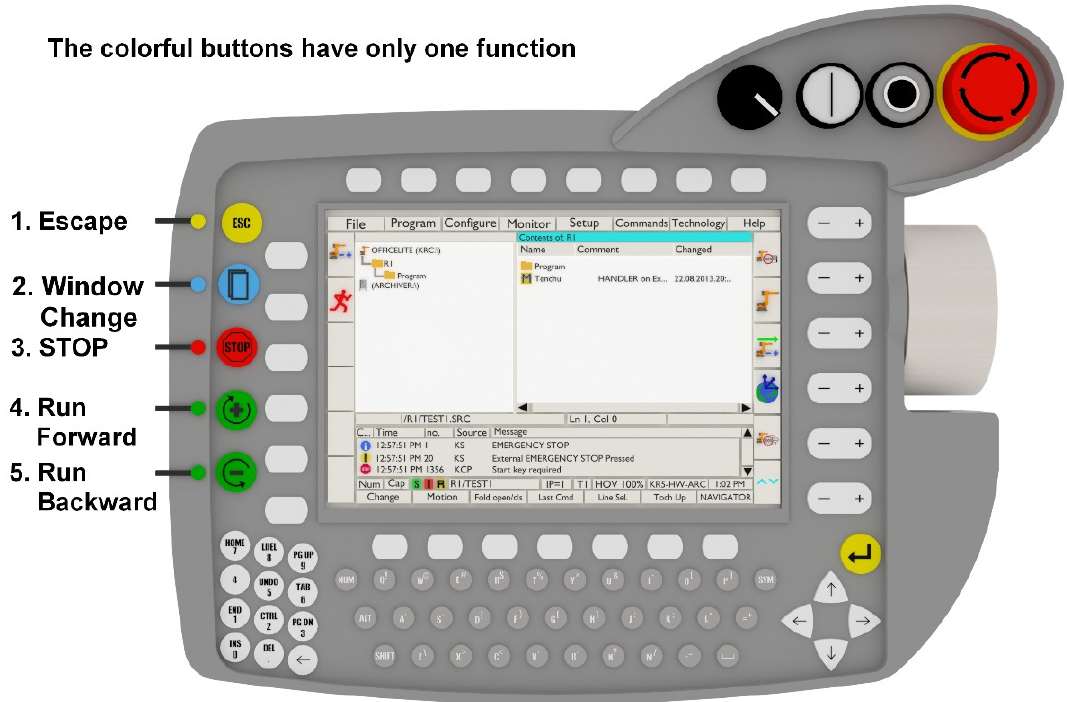
Figure 7. The Teach Pendant of KUKA KR5.